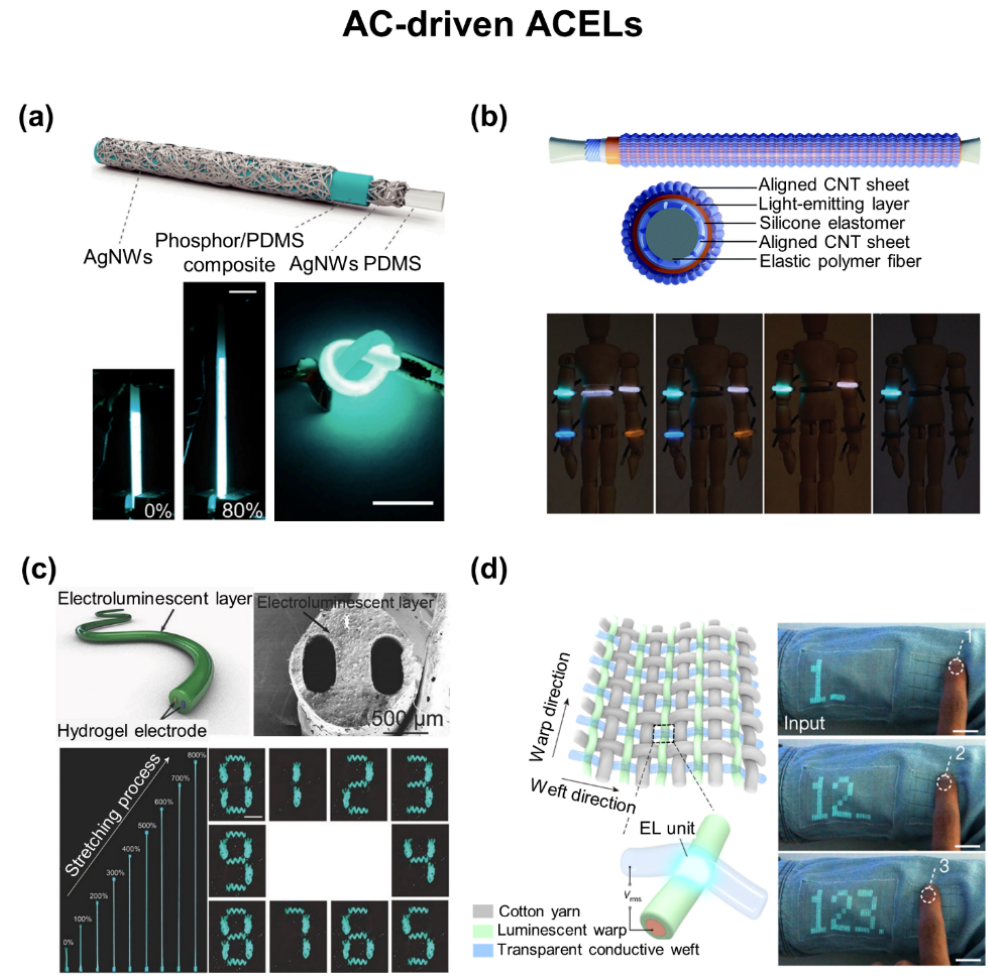
Figure 8. E-textiles for AC-driven ACELs. ( a ) Stretchable ACEL fiber with Ag NW electrodes. Reprinted with permission from [186]. Copyright 2018 MDPI. ( b ) Color-programmable ACEL fiber with aligned CNT sheets. Reprinted with permission from [187]. Copyright 2018 Royal Society of Chemistry. ( c ) Stretchable ACEL fiber with ionic hydrogel electrodes. Reprinted with permission from [188]. Copyright 2018 Wiley-VCH. ( d ) ACEL fabric with transparent conducting wefts and luminescent warps. Reprinted with permission from [36]. Copyright 2021 Springer Nature.